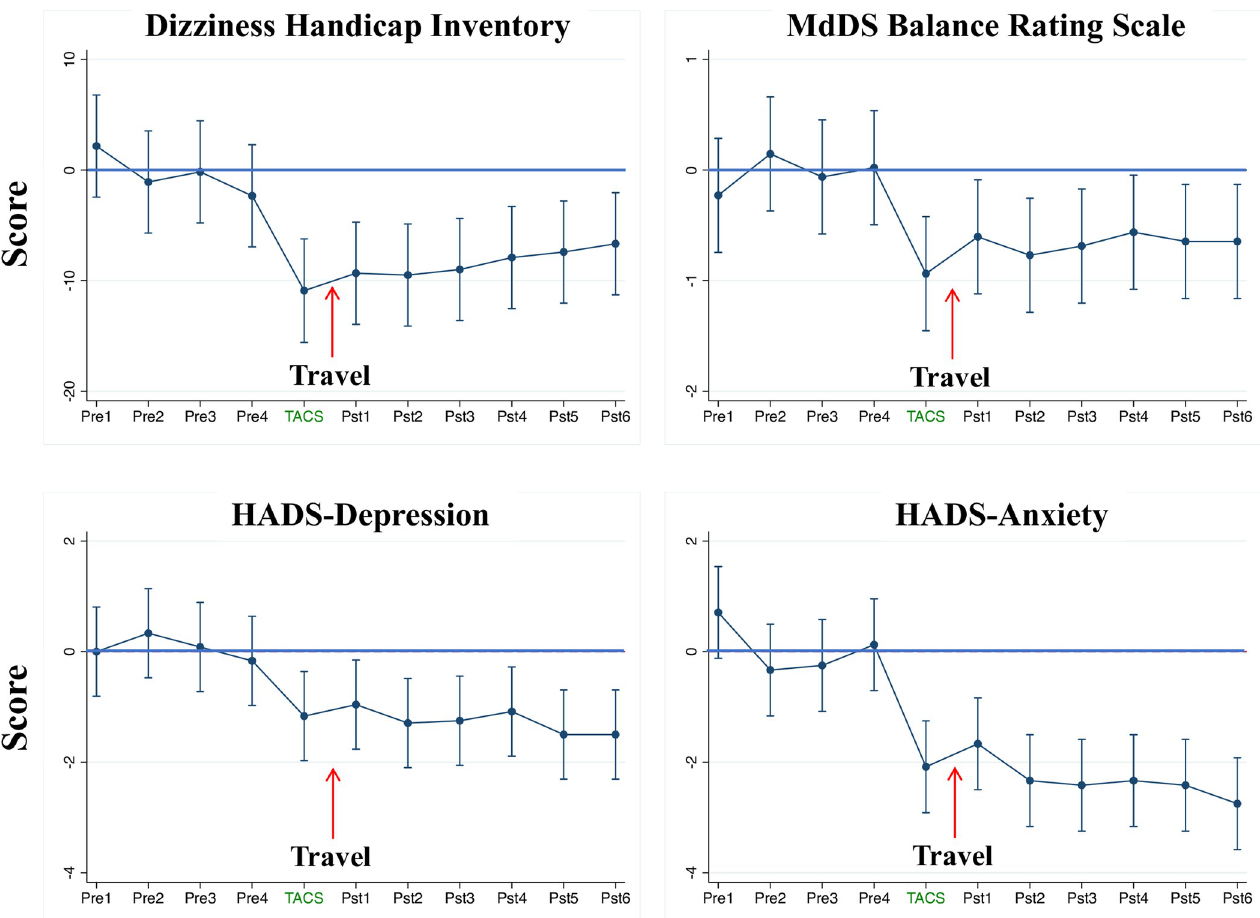
Fig 6. Longitudinal tACS effects on DHI, MBRS, and HAD scores. Linear prediction model of repeated measures ANOVA with 95% confidence intervals presented for four baseline measurements, post TMS week, and six weeks post treatment for the DHI, MBRS, and the HADS Anxiety and Depression components. Pre = pre TMS scores, Pst = post TMS